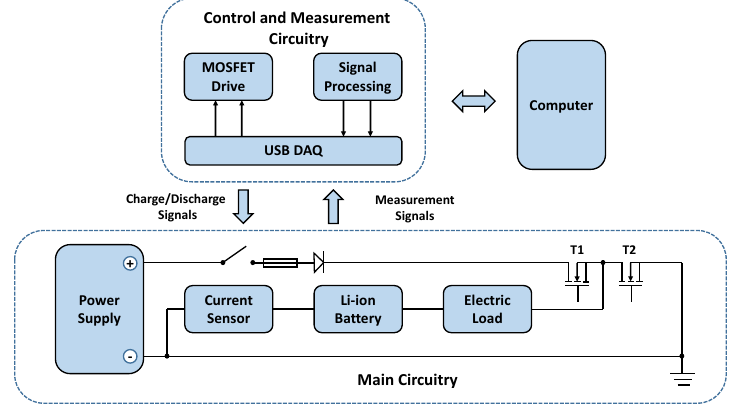
Figure 3. Schematic of the experimental battery tester. DAQ: data acquisition.